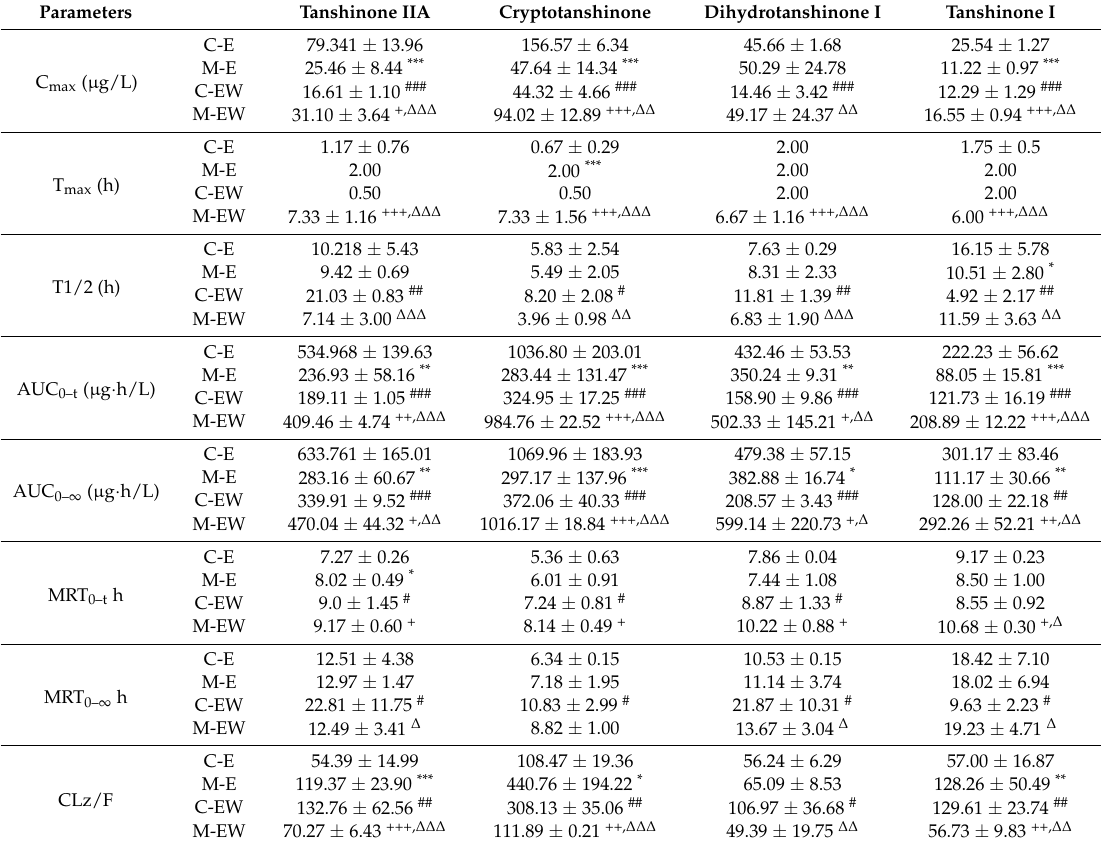
Table 6. Pharmacokinetics parameters of the four tanshinones after intragastric administration of SMEE or SMEE and SMWE (mean ± SD, n = 6). C-E: Intragastric administration Salvia miltiorrhiza ethanol extract to normal rats; M-E: Intragastric administration Salvia miltiorrhiza ethanol extract to CRF rats; C-EW: Intragastric administration Salvia miltiorrhiza ethanol extract and water extract to normal rats; M-EW: Intragastric administration Salvia miltiorrhiza ethanol extract and water extract to CRF rats. * p <